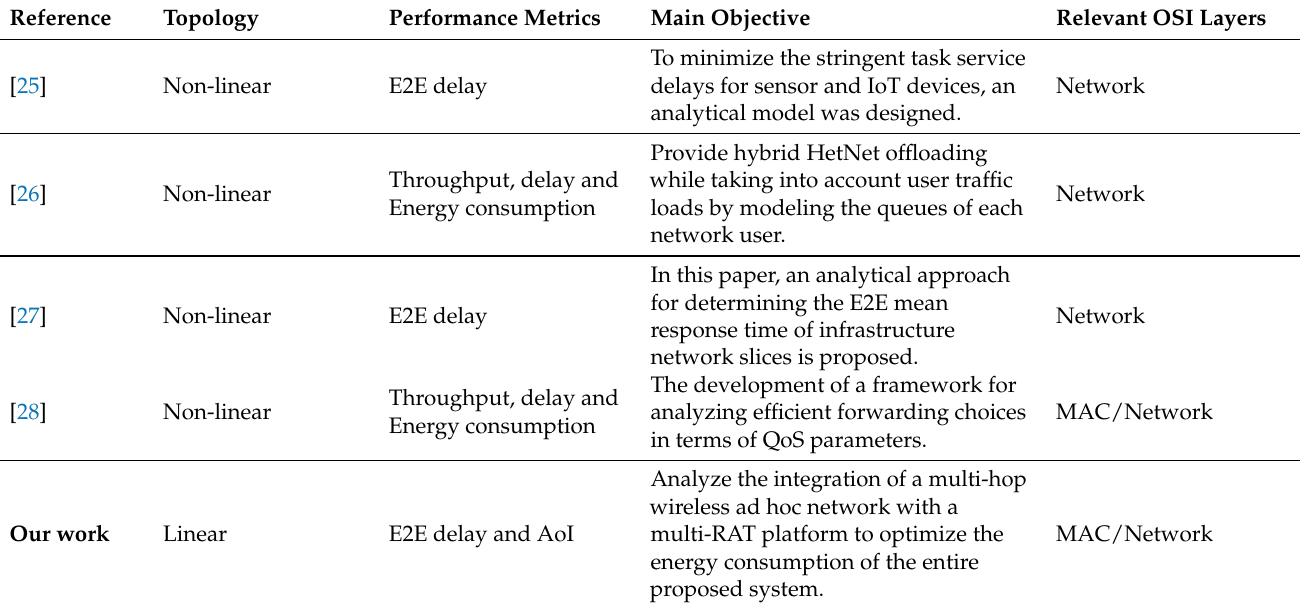
Table 1. Comparison between our proposal and related